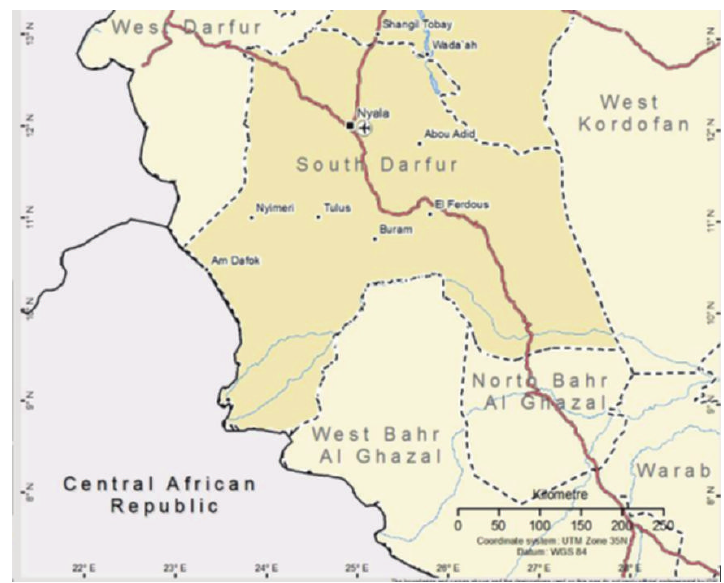
Figure 1: Geographical location of the study area, South Darfur State